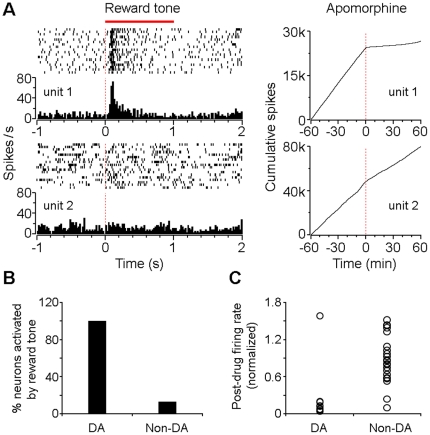
Classification of VTA putative DA and non-DA neurons.(A) Left panels, peri-event rasters and histograms of two simultaneously recorded VTA neurons (unit 1: putative DA neuron; units 2: non-DA neuron) in response to the conditioned tone (5 kHz, 1 sec) that reliably predicted food delivery. Right panels, cumulative spike activity of the same two neurons before and after (-60-0 and 0–60 min, respectively) the injection of the dopamine receptor agonist apomorphine (1 mg/kg, i.p.). (B) Percentages of classified putative DA (100%; n  =  25) and non-DA neurons (13%; 6/47) that were significantly activated by the conditioned tone that reliably predicted food delivery. (C) Normalized firing rates of putative DA and non-DA neurons after the injection of apomorphine (firing rates averaged for 30 min). Note that 9 out 10 putative DA neurons tested showed significant suppression (≤ 20% baseline firing rates), while the majority of the non-DA neurons (20/22) showed limited or no change of firing rate by apomorphine (1 mg/kg, i.p.).